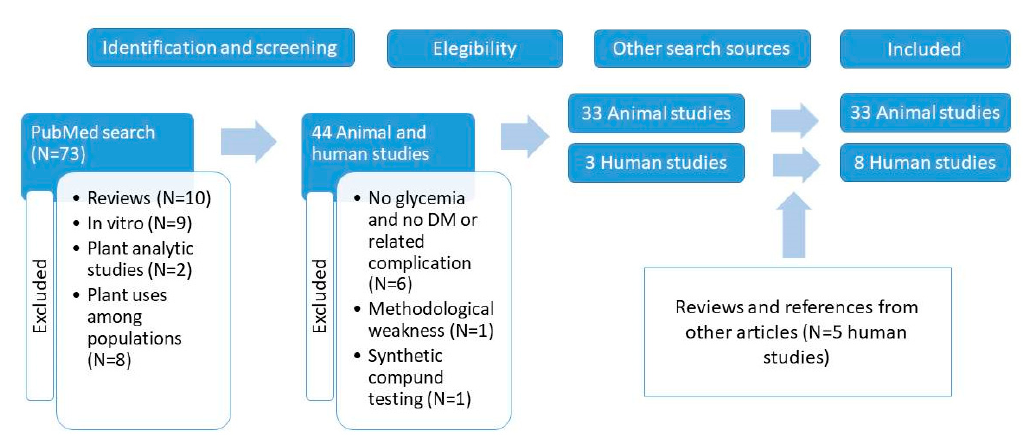
Figure 1. Flow chart of the selection of the animal and human studies included. DM: diabetes mellitus.